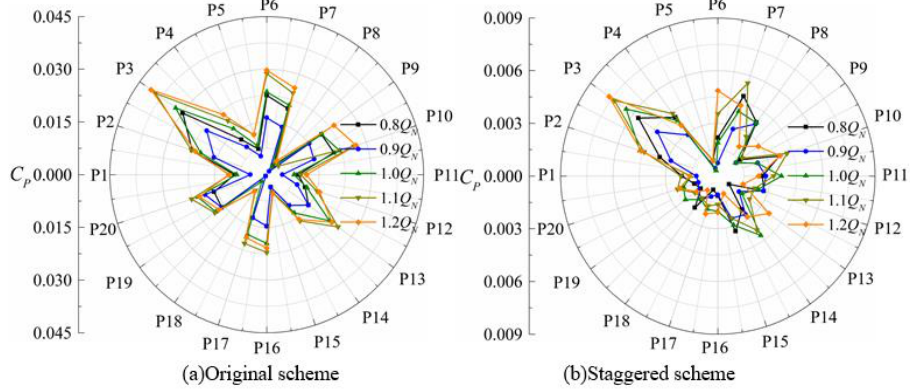
Figure 6. Frequency domain comparison of measured values of different scheme.